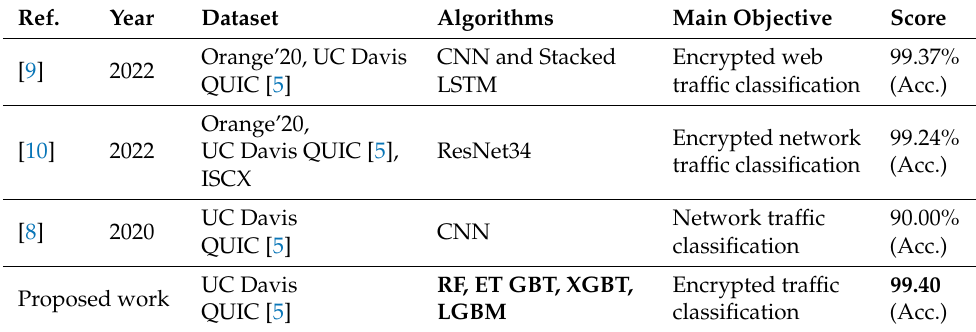
Table 11. Comparison between the proposed work and others in the literature. Ref.